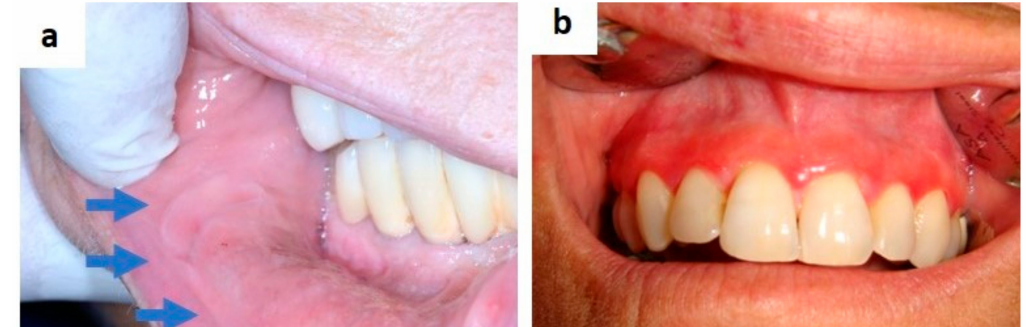
Figure 13. ( a , b ) Mucosal tags of cheek in patient with Chron’s disease ( a ); persistent and diffuse erythematous gingivitis at the maxilla as first manifestation of the disease in absence of intestinal symptoms ( b